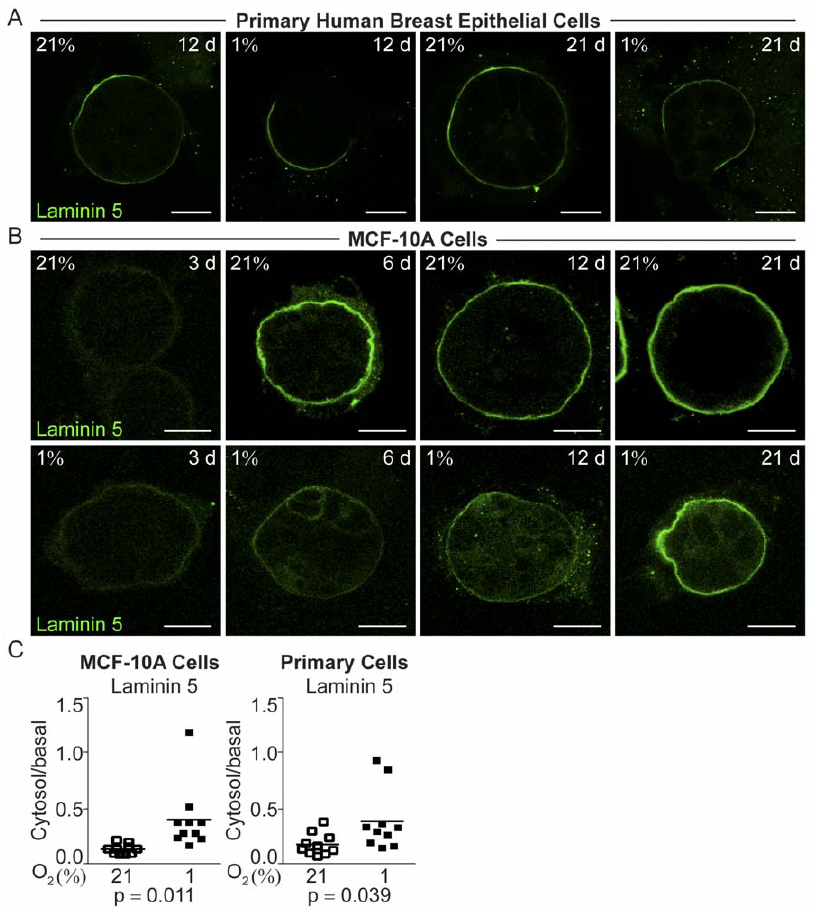
Figure 4. Functional and structural polarization of human breast epithelial cell organoids grown at 21% and 1% oxygen illustrated by the marker of breast epithelial differentiation and polarization laminin 5. A. Laminin 5 (green) immunofluorescence staining of human primary breast epithelial cells after 12 and 21 days of 3D-culture on ECM-derived substrate under normoxic (21%) or hypoxic (1%) conditions. Images from one representative of three independent experiments with cells from different individuals are shown. Size bars 20 m m. B. Immunofluorescence of laminin 5 (green) performed after 3, 6, 12, and 21 days of culture of MCF-10 cells in 3D-culture on ECM-derived substrate under normoxic (21%) or hypoxic (1%) conditions. All confocal micrographs were acquired at the Z-plane where the depictured acini-like structure had the widest circumference. Size bars 20 m m. C. The ratio of intra cellular to basal cell membrane mean fluorophore intensity in normoxic (open) and hypoxic (black) MCF-10A cells (left panel) and primary human breast epithelial cells (right panel) 21 days post-seeding, measured in one representative cell in ten different organoids. Statistical analysis was performed with Student’s t-test (p).In agreement with the non-malignant status of both the primary breast epithelial and the MCF-10A cells we found HMFG/MUC1 to have a polarized localization in normoxic acinar cells 21 days post-seeding (Fig. 5A, B). The basal, as opposed to apical, localization of this protein is in agreement with MCF-10A cells showing little apical polarization as previously reported [27]. HMFG/MUC1 displayed a decrease in polarized localization in both primary breast epithelial and MCF-10A cells at hypoxia (Fig. 5A, B). In the MCF-10A cells there was a significant difference in the ratio of intra-cellular to basal localization at hypoxia compared to normoxia (p , 0.0001, Fig. 5C). The ratio of cytosolic to basal membrane localization could not be reliably determined in the primary breast epithelial cells. The MUC1 mRNA expression was significantly decreased in the hypoxic MCF-10A cells after 21 days of 3D-culture (p=0.013, Fig. 5D). doi:10.1371/journal.pone.0046543.g004 number of tissue-specific basic helix-loop-helix transcription factors instrumental during development and differentiation of numerous organs. In mammary gland differentiation, forced